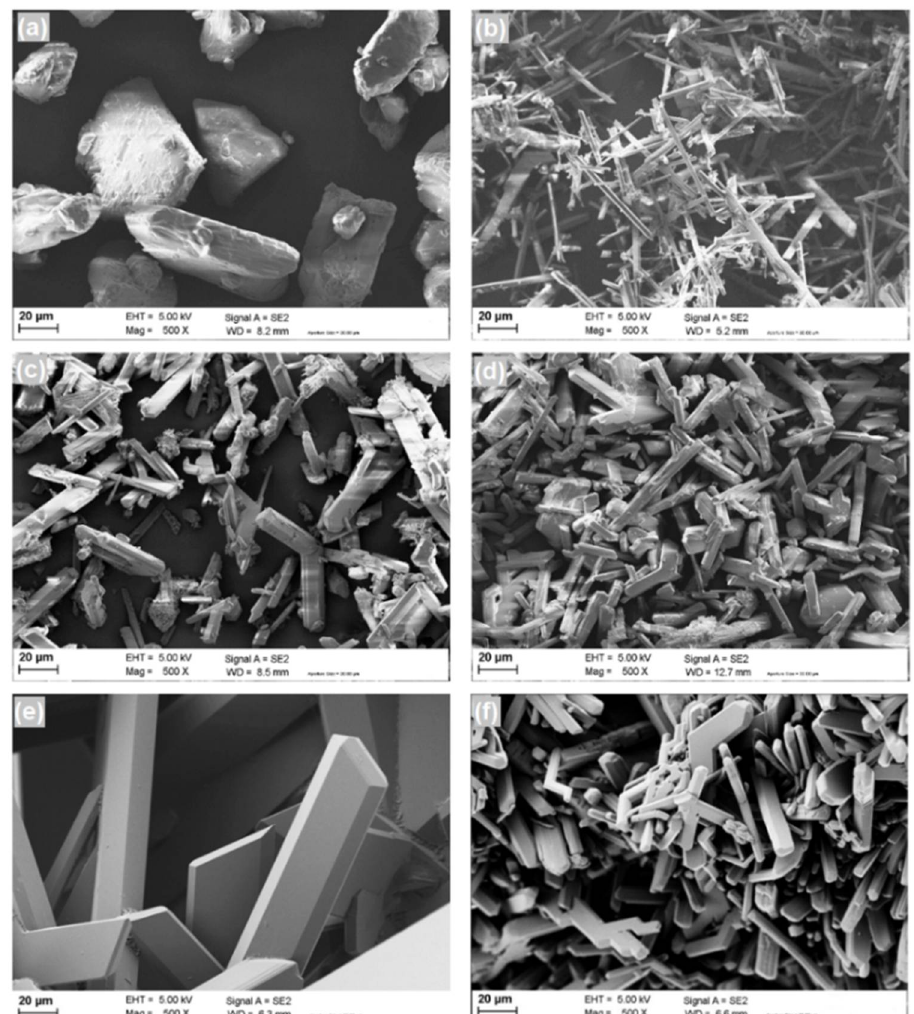
Figure 7. SEM images of NaHCO 3 , comparing commercial crystals ( a ) with crystals obtained using osmotic membrane distillation crystallization at different temperatures: ( b ) 15 ◦ C; ( c ) 20 ◦ C; ( d ) 30 ◦ C; ( e ) 35 ◦ C; ( f ) 40 ◦